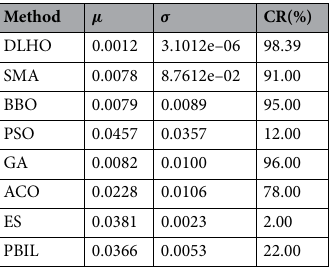
Table 11. Algorithms outcomes for the Breast Cancer detection on second database.